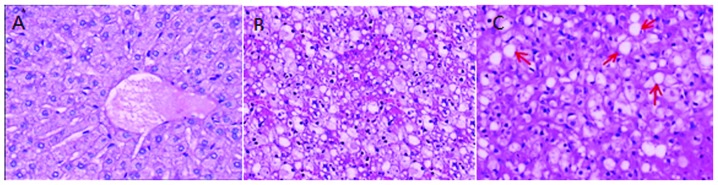
Hematoxylin and eosin staining of the rabbit liver observed under a microscope (magnification, ×200). (A) Liver from a normal rabbit; liver cell cords arranged in order with occasional lipid droplets in the liver cells. (B) Non-alcoholic fatty liver; a large number of large-droplet liver cells were apparent, which accounted for ~50% of the total area. (C) Alcoholic fatty liver; large-droplet liver cells accounted for ~80% of the total area, the foam-like cells are indicated by red arrows.